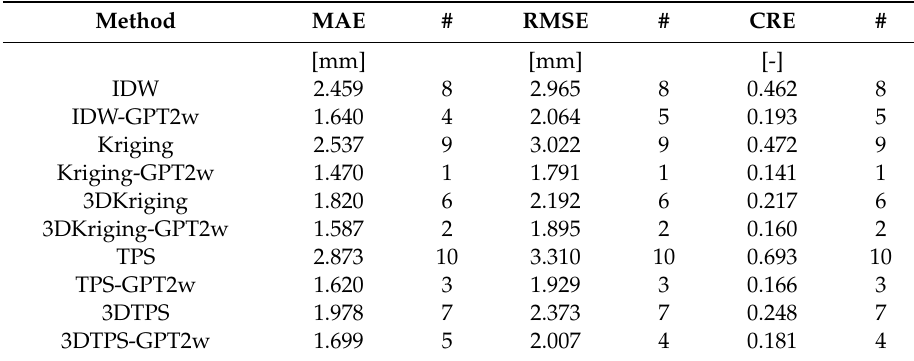
Table 2. Summary of the performance evaluation of di ff erent interpolation schemes for grid points comparison with the ECMWF data.